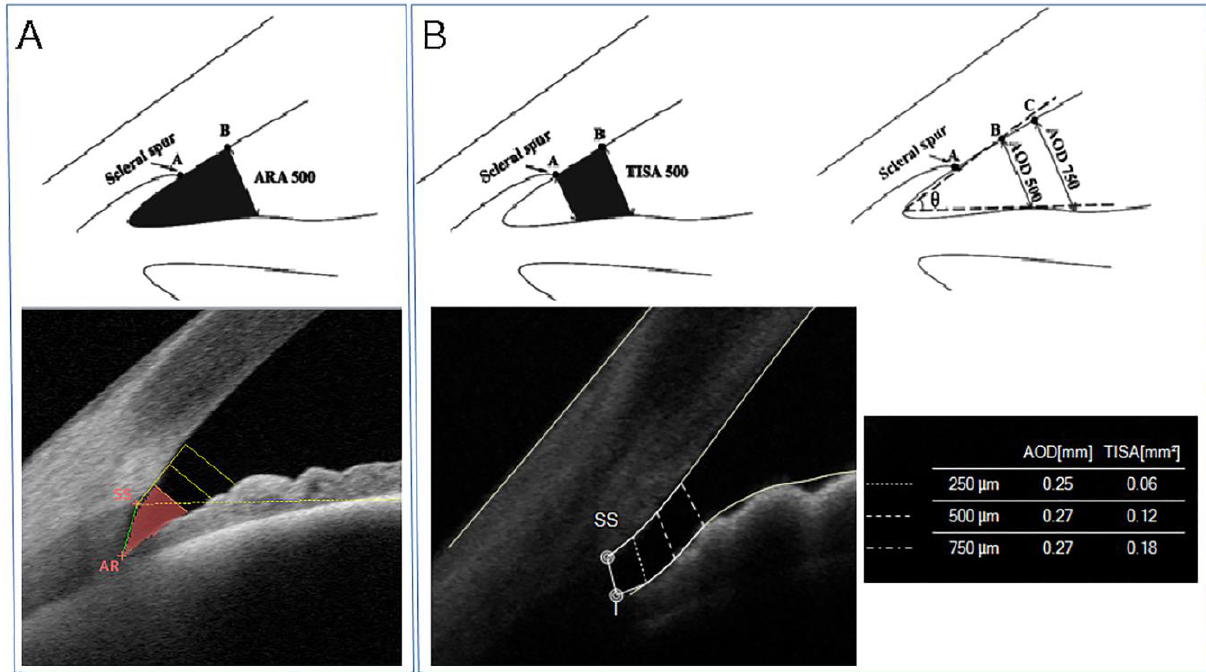
Figure 3. ( A ) Top panel. Schematic diagram of the angle-recess area at 500 microns from the scleral spur (ARA500, black area). Bottom panel. Tomey Casia 2 AS-OCT scan (Nagoya, Japan) of the angle showing in vivo ARA500 (red area). ARA is defined as the triangular area bordered by the anterior iris surface, corneal endothelium, and a line perpendicular to the endothelium drawn from a point anterior to the scleral spur to the iris surface. ( B ) Top panel. Schematic diagram of the trabecular iris-space area at 500 microns from the scleral spur (TISA500, black area, top left panel) and the angle-opening distance at 500 and 750 microns from the scleral spur (AOD500 and AOD750, respectively, top right panel). Bottom panel. MS-39 AS-OCT scan (CSO, Florence, Italy) of the iridocorneal angle showing in vivo TISA and AOD. AOD is the perpendicular distance from the iris to the trabecular meshwork, which can be measured at different distances anterior to the scleral spur, such as 250, 500, 750 microns (AOD250, AOD500, AOD750, respectively). TISA, which again can be evaluated at several distances from the scleral spur (SS), is defined as the trapezoidal area with the following boundaries: anteriorly, the AOD; posteriorly, a line perpendicular to the plane of the inner corneoscleral wall drawn from the scleral spur to the opposing iris; superiorly, the inner corneoscleral wall; and inferiorly, the anterior iris surface. Some other parameters involve iris measurements. The iris thickness (IT) is the thickness of the iris at different distances from the SS (e.g., IT500, IT750) (Figure 4A). The iris area is defined as the entire cross-sectional area of the iris from the SS to the pupil (Figure 4B). The iris curvature is the perpendicular distance from the iris-pigmented epithelium at the point of greatest convexity to a line between the most peripheral and the most central points of the iris-pigmented epithelium [13,15], as shown in Figure 4C.